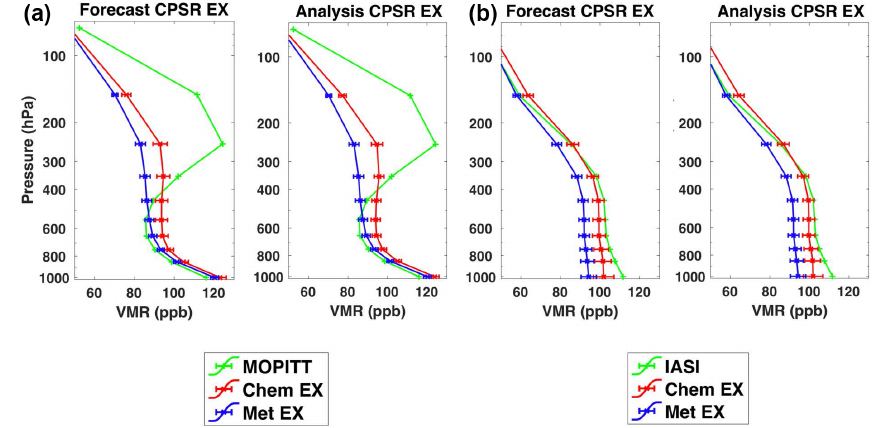
Figure 7. Vertical profiles of the time/horizontal domain average CO in ppb from the CPSR and MET experiments for 9 June 2008, 18:00UTC, in retrieval space. “Forecast” is the assimilation prior, and “analysis” is the assimilation posterior. Panel (a) compares the forecast/assimilation results against MOPITT CO retrievals (assimilated), and panel (b) compares those results against IASI CO retrievals (not assimilated). In the legends, Chem EX refers to the CPSR experiment. The error bars are based on the ensemble